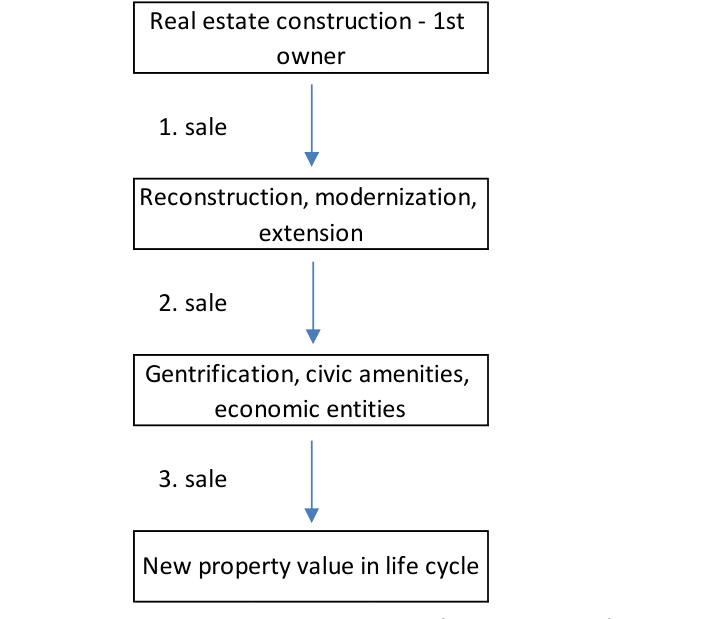
Figure 3: Life cycle of marketable real estate (source: